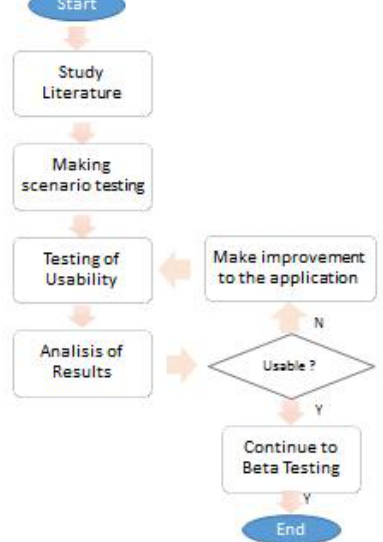
Figure 1. The flow diagram of the research on usability testing